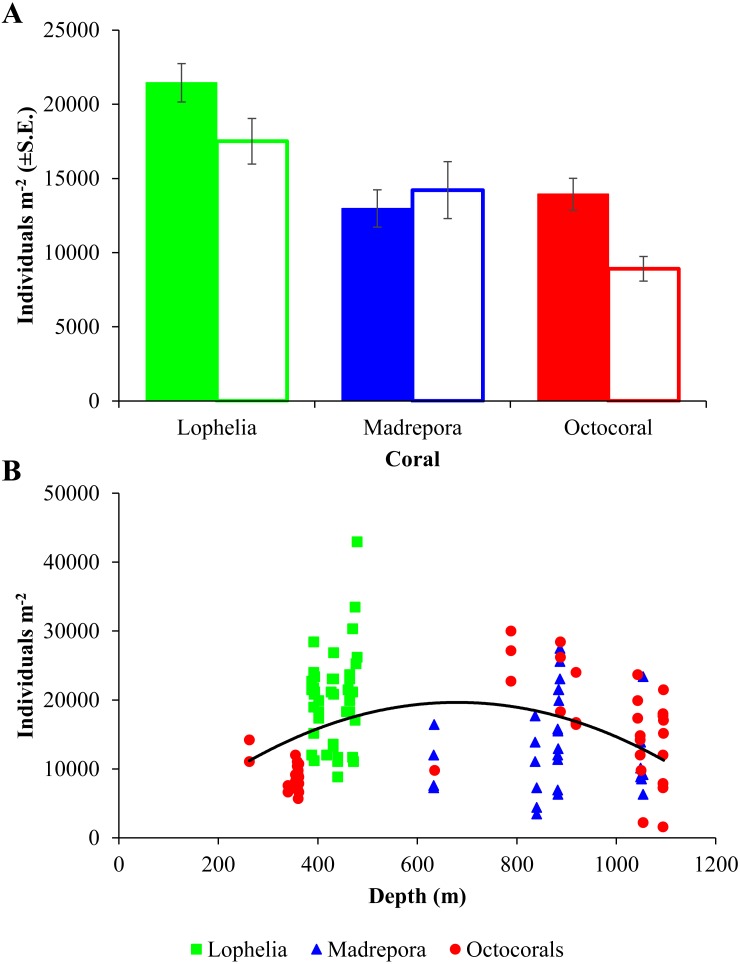
Macrofaunal density at deep-sea coral habitats.(A) Mean macrofaunal density (individuals m−2 ±  1 S.E.) near coral (solid bars) and background (open bars) soft-sediment habitats in the GOM. (B) Macrofaunal density (individuals m−2) of near-coral cores with depth, with polynomial trendline delineated (y =  − 0.0475x2 + 63.81x − 1579, R2 = 0.101).